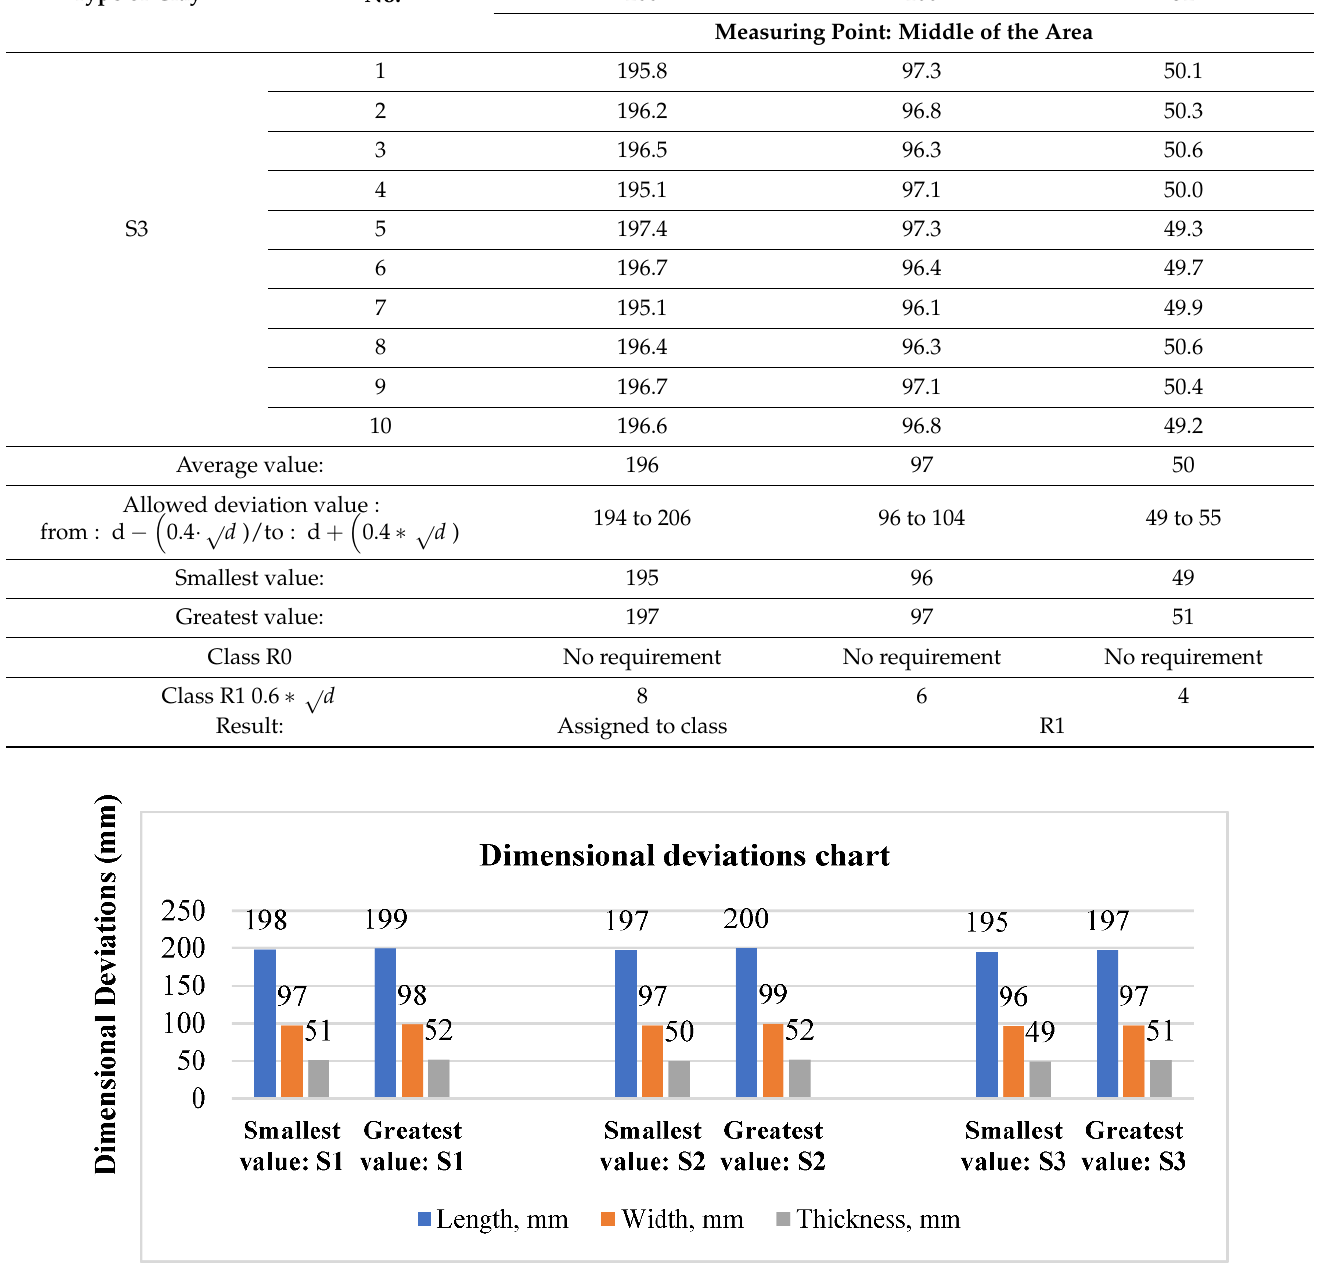
Figure 7. Results of dimensional differences and deviations. The highest dimensional deviations were recorded in the specimens manufactured from clay type S3 and the most resistant to expansion and shrinkage were specimens from clay type